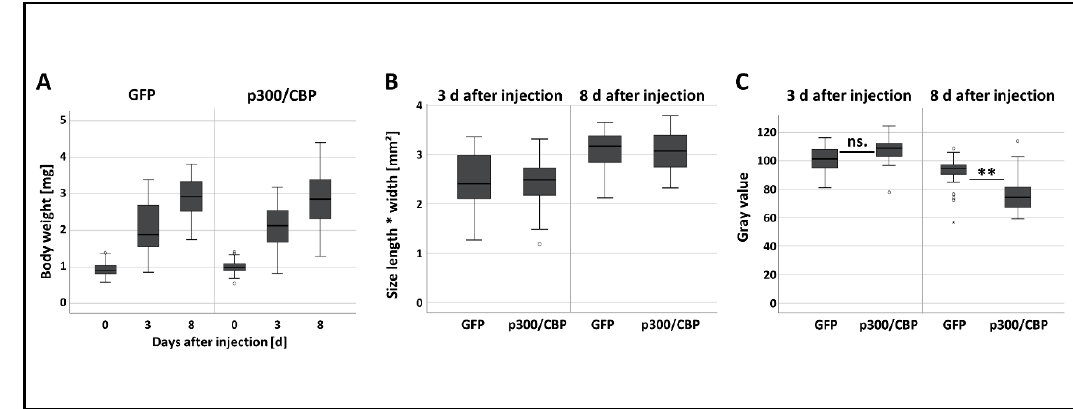
Figure 5. Life-history parameters following the RNAi-mediated attenuation of p300/CBP in A. pisum . ( A ) Bodyweight, ( B ) body size and ( C ) body color were determined on days 3 and 8 after treatment with 3000 ng/µL p300/CBP or GFP dsRNA. Aphid weight and size did not differ significantly between the p300/CBP treatment and GFP control groups. Data were analyzed using Student’s t -test. Statistical significance is indicated as follows: ** p < 0.01, ns—not significant.